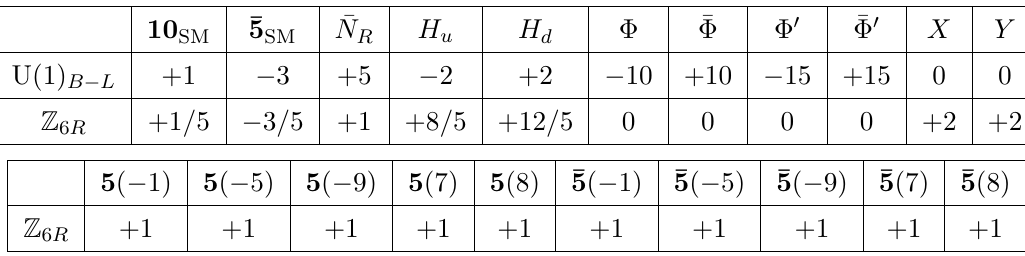
Table 1 . The charge assignment of the B (cid:0) L symmetry and the gauged Z 6 R symmetry. For additional 5 and (cid:22) 5 , corresponding B (cid:0) L charges are shown in the